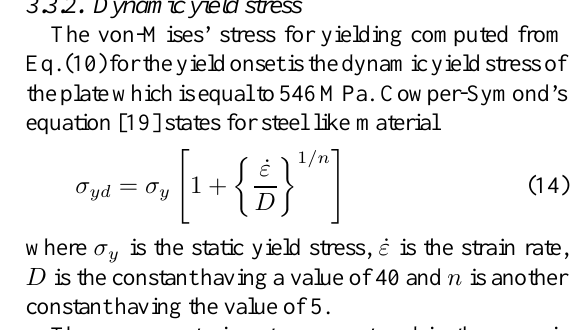
Table 6 Summary of validation experiment results in comparison with em- pirical prediction for circular plates Shot